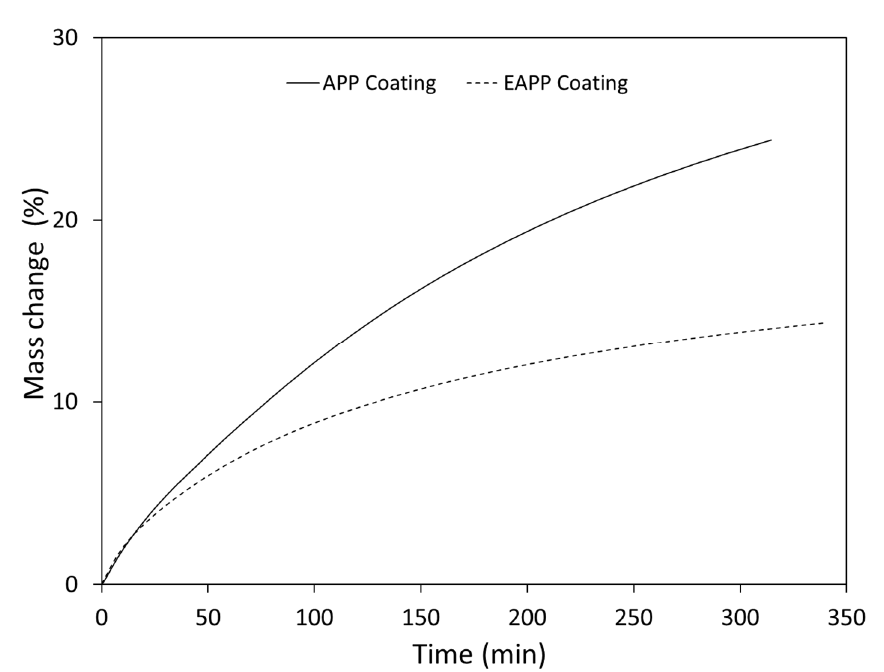
Figure 2. Water absorption curves of coating films.